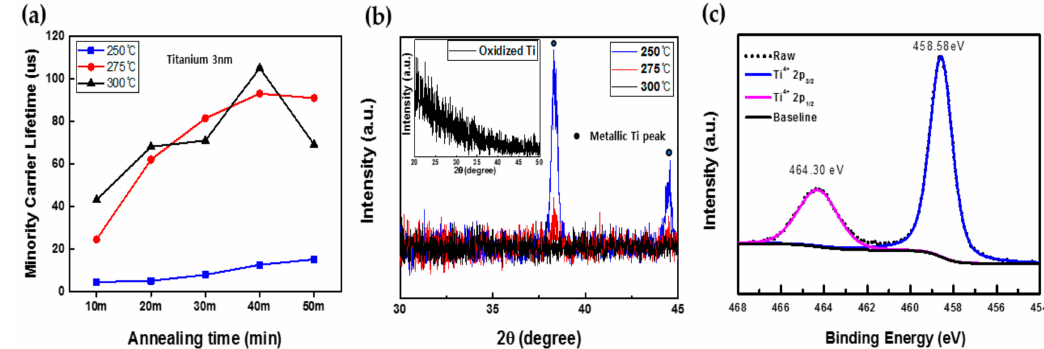
Figure 4. ( a ) Lifetime according to oxidation temperature and time, ( b ) GIXRD spectra (inside figure is broader range of GIXRD peak), and ( c ) Ti 2 p XPS spectra of an oxidized titanium